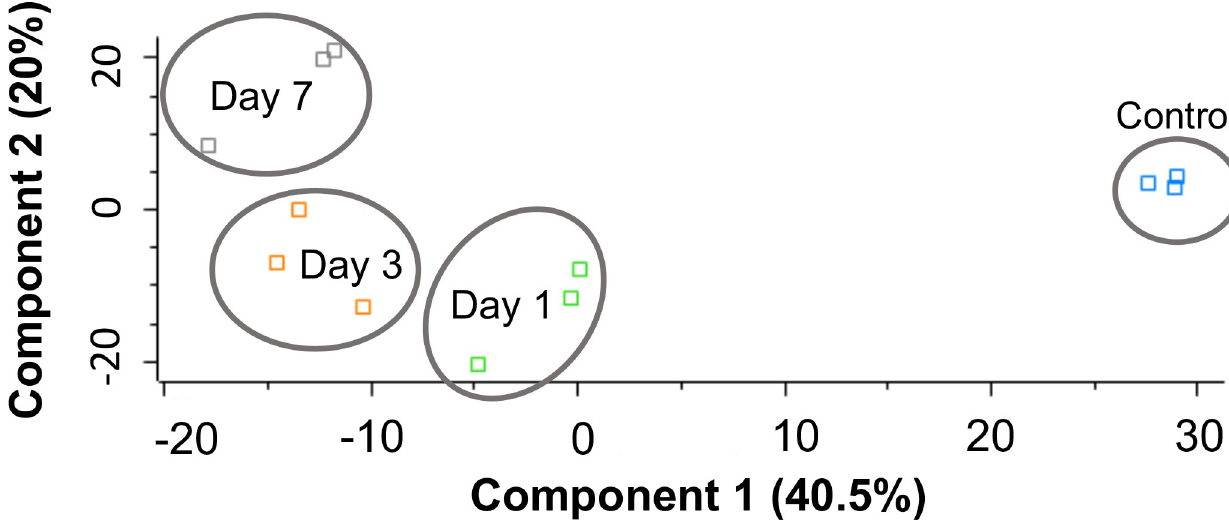
Fig 3. Shotgun quantitative proteomic analysis of hemolymph proteome following infection with M . mycetomatis . Principal component analysis (PCA) of control larval hemolymph proteome (0 hour) and infected larval hemolymph proteomes following infection with M . mycetomatis after infection for 24 hour, 72 hour and 7 days with a clear distinction between control and infected